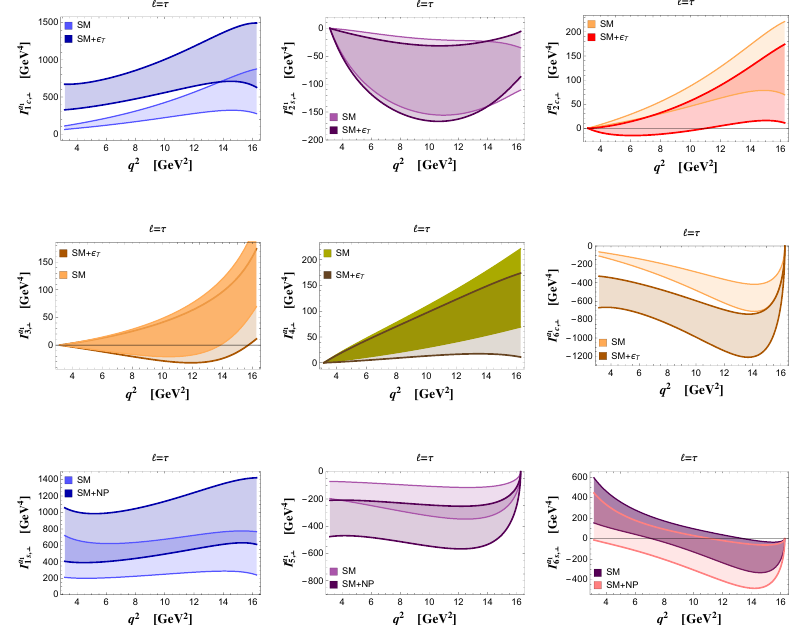
Figure 17. Angular coefficient functions for ¯ B → a 1 ( ρ ⊥ π ) τ − ¯ ν τ (same notations as in Figure